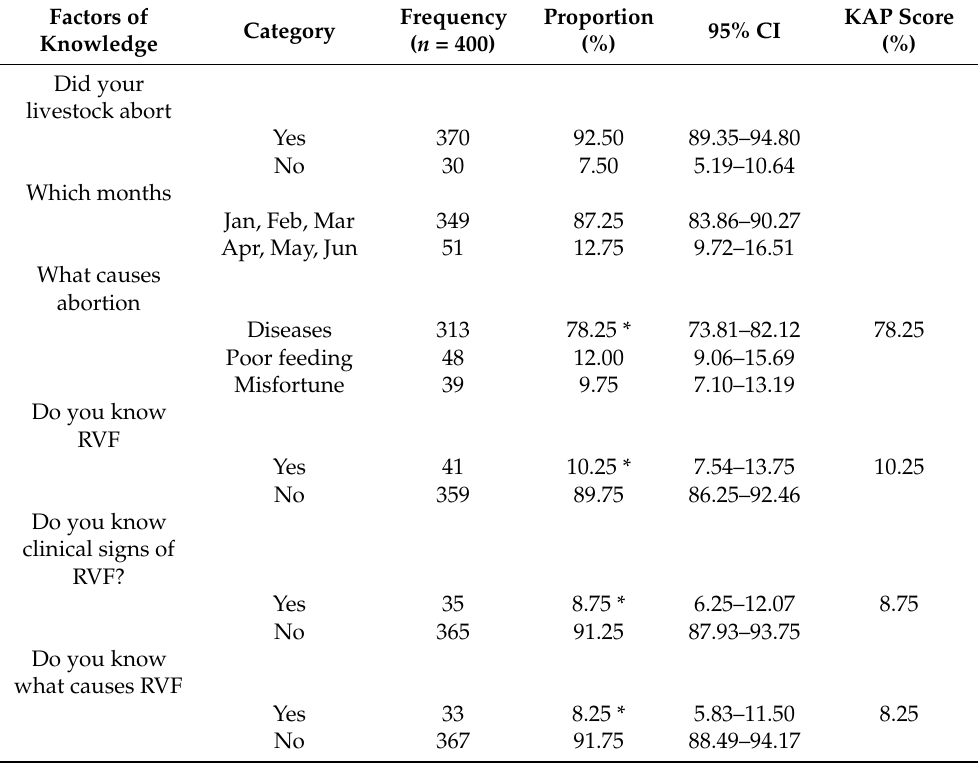
Table 2. Participants’ knowledge of Rift Valley